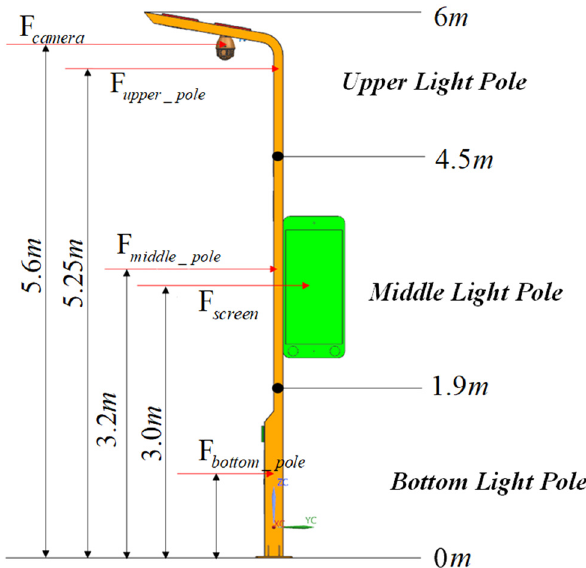
Figure 4: Schematic of the smart light pole subjected to wind load.